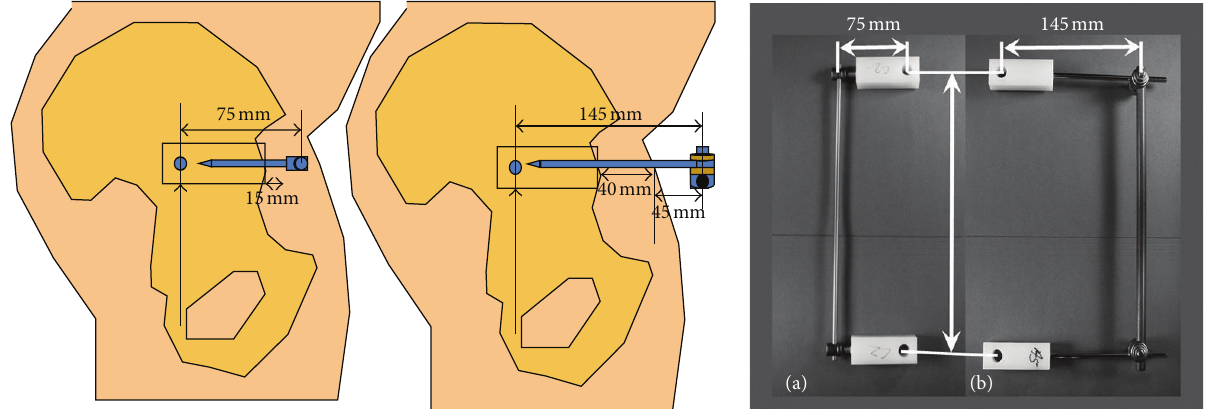
Figure 2: Measurements of the set-up for testing in polyethylene blocks.